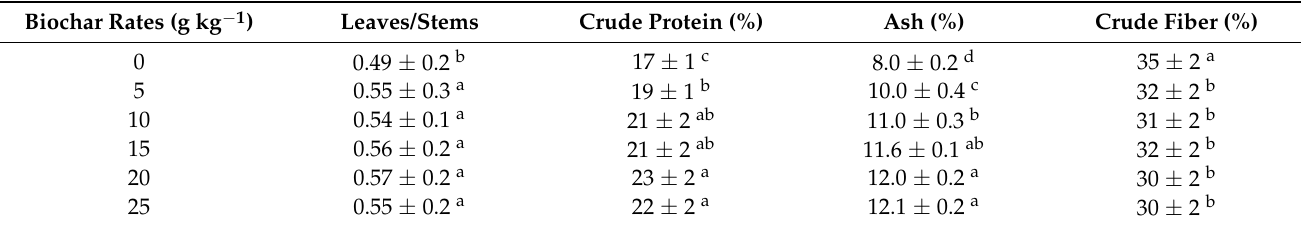
Table 6. Effect of SWB on the forage quality of pearl millet.